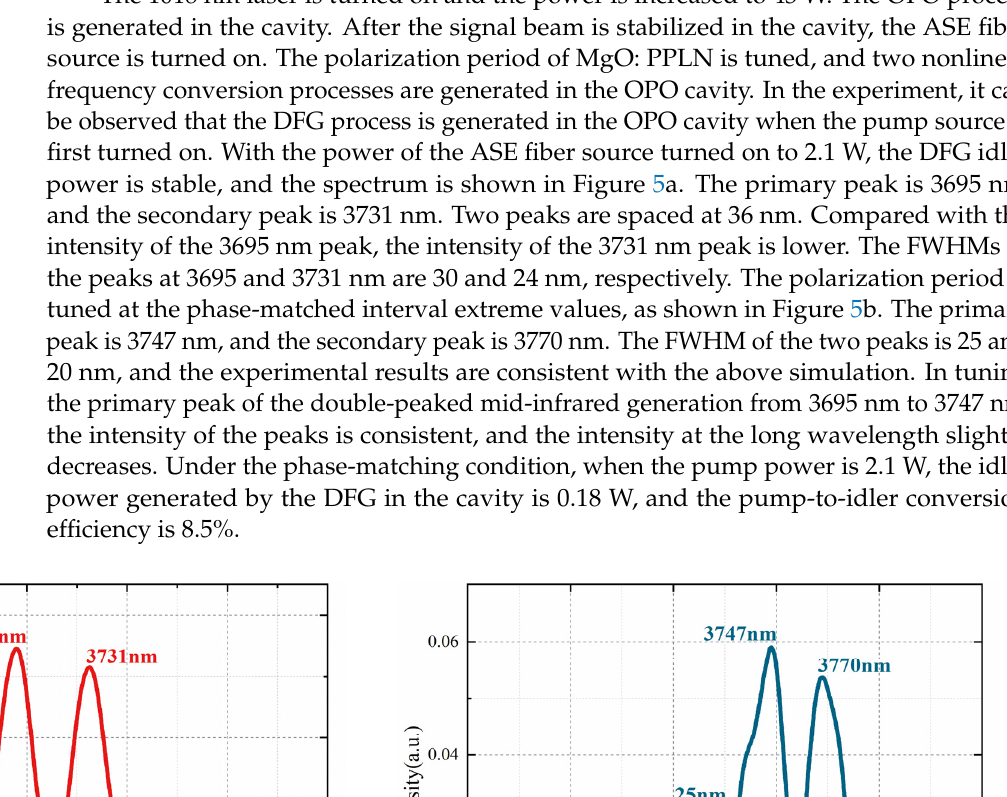
Figure 4. Simulated double-peaked idler beam.